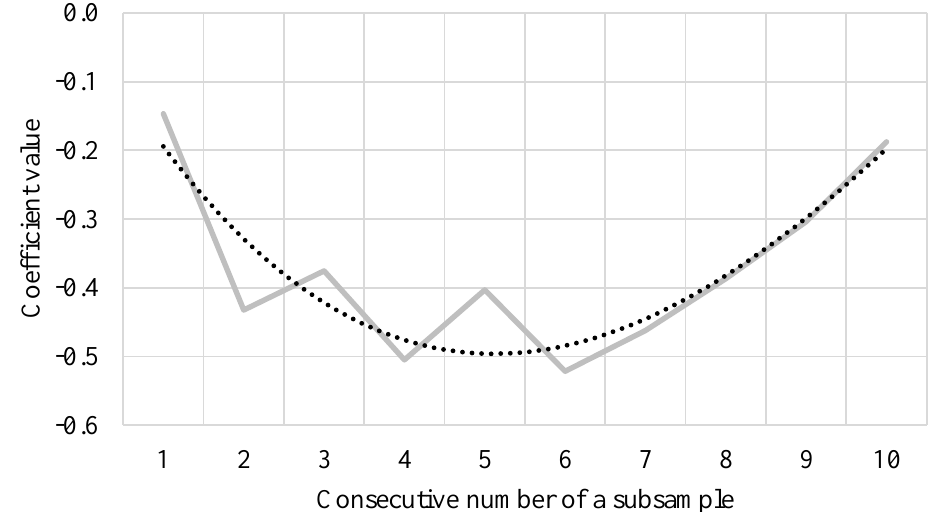
Figure 2. Coefficient value dynamics for number of payments to loan term.